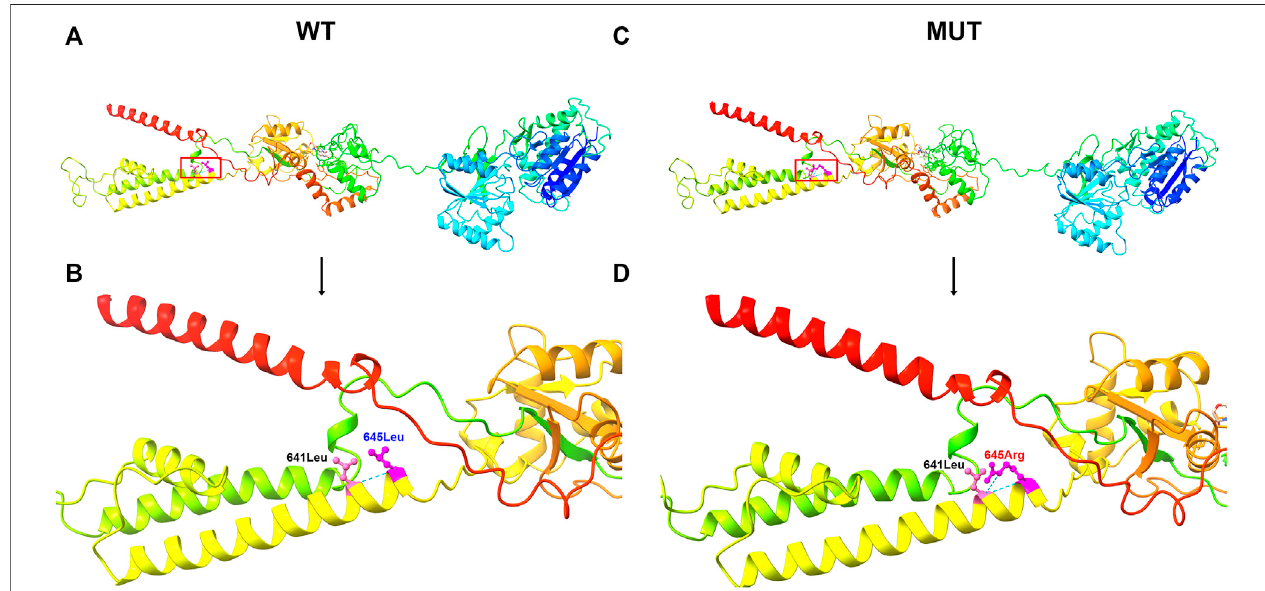
FIGURE3| 3DimageofGRIA2protein. (A) isthe3Doverallpictureofwild-type(WT) GRIA2 protein(645Leuisintheredframe). (B) isthe3Dpartialenlargedviewof wild-type GRIA2 protein.645Leu(WT)and641Leuformahydrogenbond. (C) isthe3Doverallpictureofmutant (MUT) GRIA2 protein. (D) isthe3Dpartialenlargedview of mutant GRIA2 protein. 645Arg (MUT) and 641Leu form two hydrogen bonds.